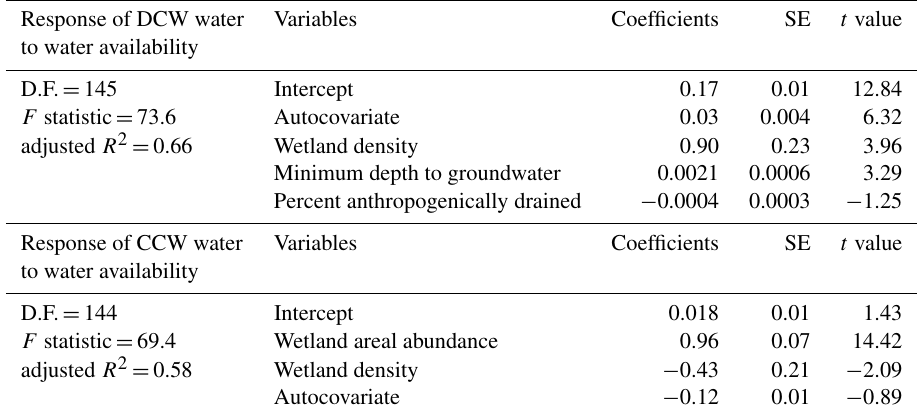
Table 8. Feasible generalized least square models with residual weights applied relating the response (of surface water extent to water availability) to landscape-related variables. All variables included in the models were significant. DCW – surface water disconnected from the stream network, CCW – continuously connected surface water, SE – standard error, and D.F. – degrees of